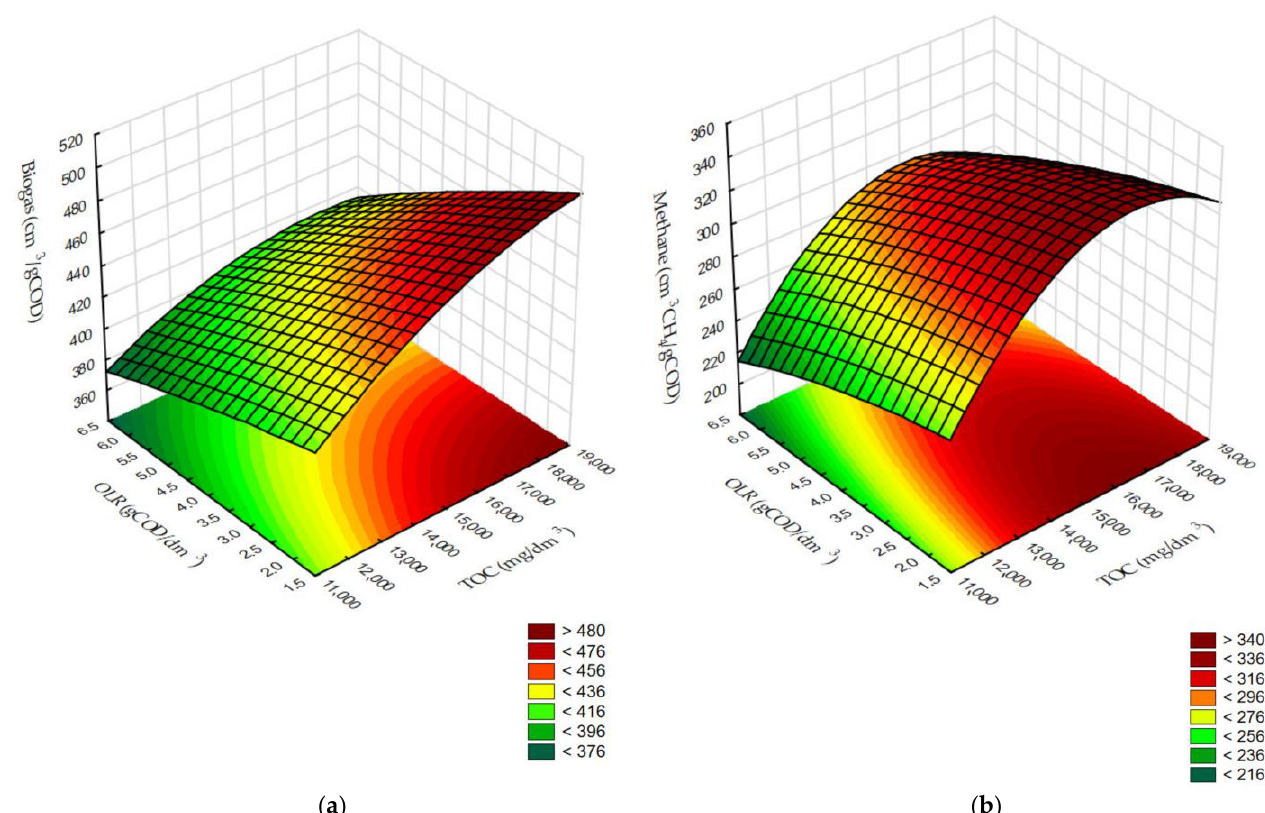
Figure 7. Surface correlation between COD concentration in the supernatant and OLR and the ( a ) biogas and ( b ) methane yields.